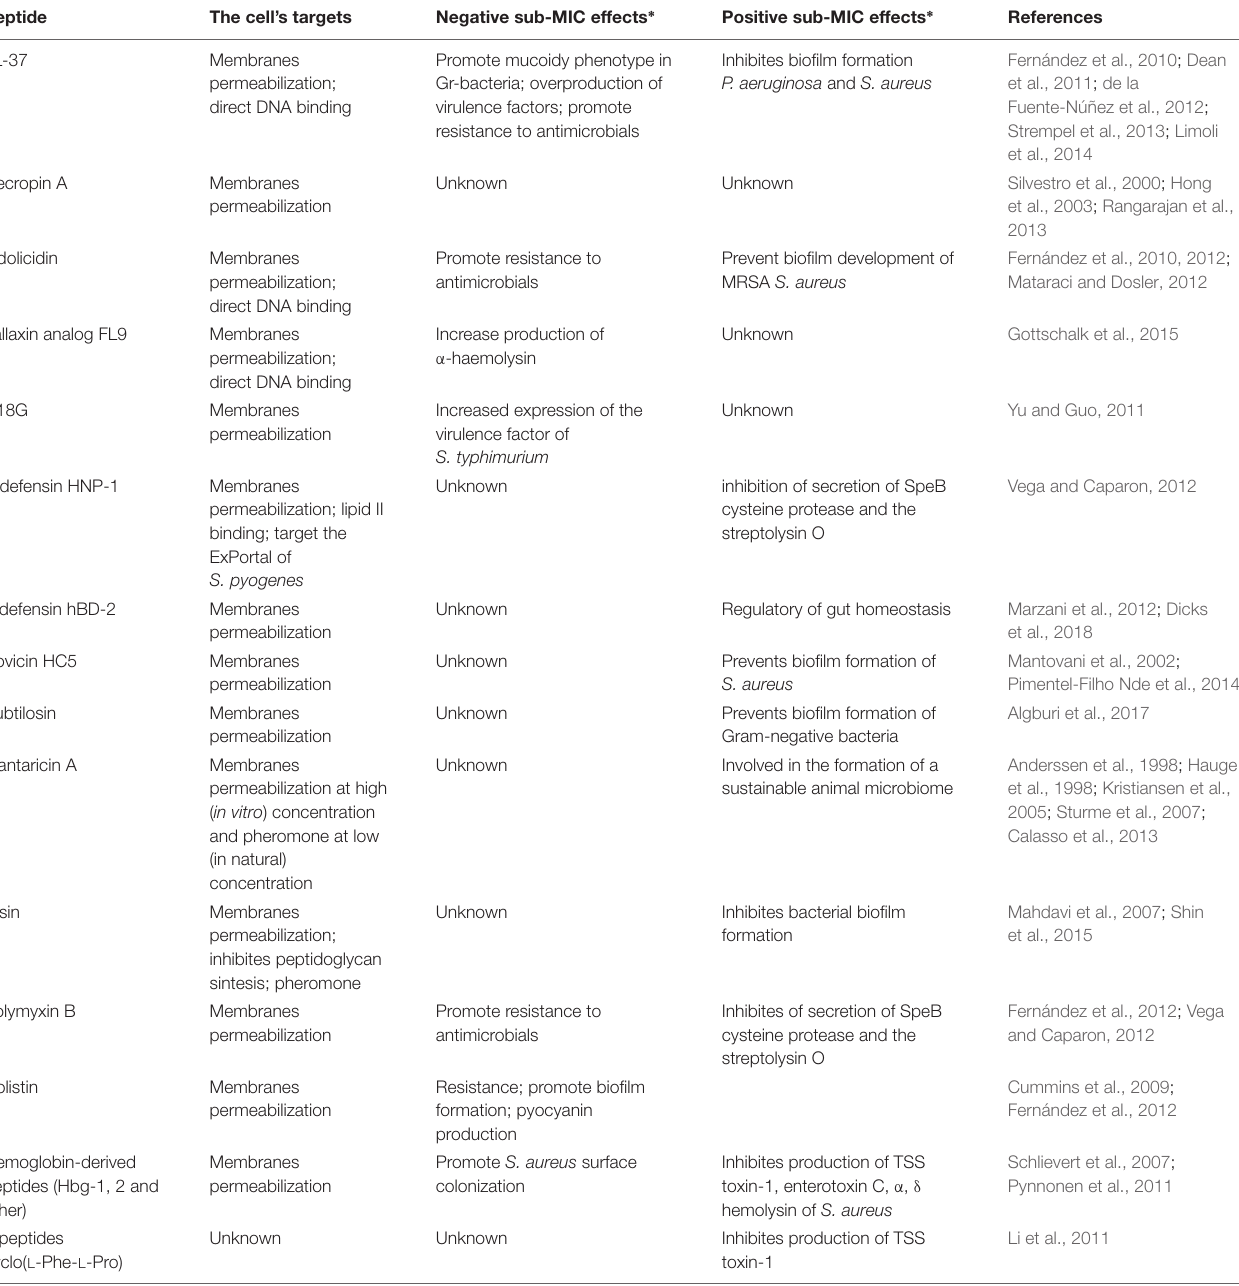
TABLE 2 | The mode of action and sub-inhibitory effects of peptides described in the review.